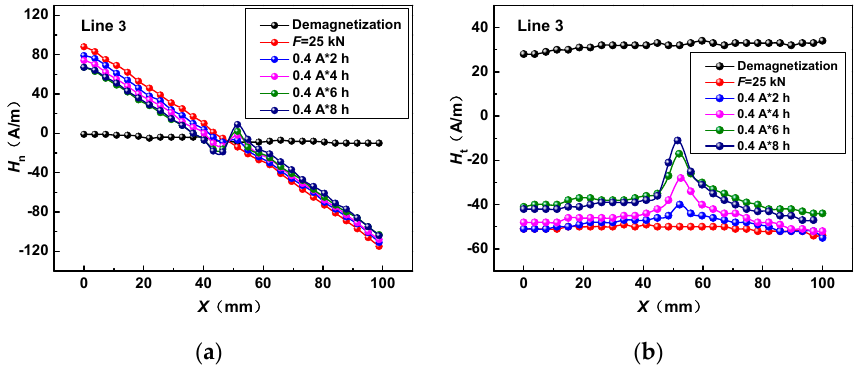
Figure 7. MFL signals distributions of normal and tangential components during experiment 3 (corrosion after loading) at different corrosion degrees measured on Line 3 ( a ) and ( b ), respectively.